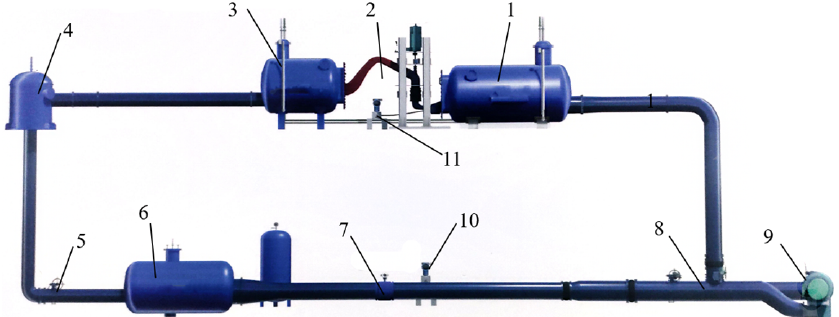
Figure 1. High-precision test bench of Yangzhou University (1. inlet tank; 2. pump section and drive motor; 3. pressure outlet tank; 4. bifurcation tank; 5. condition regulating gate valve; 6. pressure stabilizing rectifier; 7. electromagnetic flowmeter; 8. forward and reverse operation control gate valve; 9. auxiliary pump unit; 10. differential pressure transmitter; and 11. absolute pressure trans- mitter).